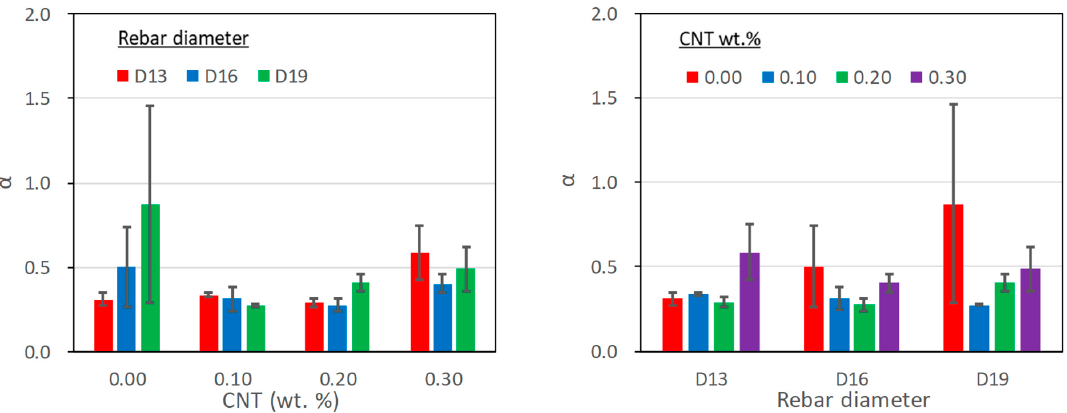
Figure 11. The effect of CNTs mix ratio and rebar diameter on 𝛼 coefficient. Table 7. Summary of the pullout test results.